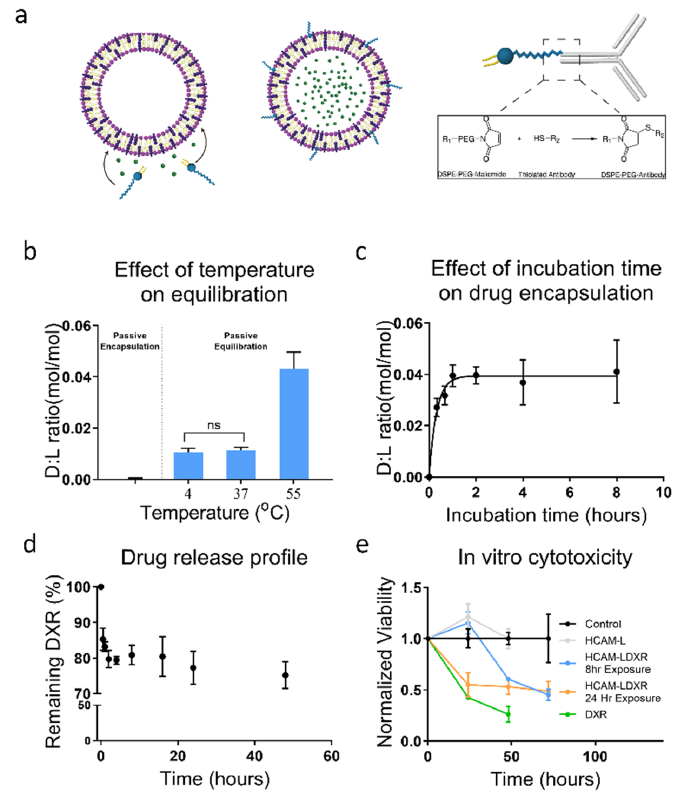
Figure 3. Thermal equilibration ( a ) Schematic of liposome encapsulation via thermal equilibration and conjugation with DSPE-PEG-MAL linked to an antibody. ( b ) The effect of temperature on equilibration was investigated by incubating DXR and liposomes at 4, 37, and 55 °C for 1 h and comparison with liposomal DXR created via passive encapsulation. E T increases D:L nearly 200 folds compared to passive encapsulation, and even at low temperatures, DXR is associated with liposomes. ( c ) Effect of incubation time on encapsulation for optimization. The liposomes showed a time-dependent increase in DXR encapsulation up to 1 h, however, beyond 1 h there was very little change. ( d ) Evaluations of DXR release profile at 37 °C in PBS with 10% FBS. A controlled escape of DXR from liposomes, with 75% (±37%) of the DXR remaining in the liposomes after 48 h was observed. (e) Targeting ability and cytotoxicity of anti-HCAM conjugated DXR liposomes on breast cancer cells. MDA-MB-231 DSPE-PEG-MAL was integrated within the membrane during equilibration and incubated with an antibody (HCAM). These targeted liposomes were cytotoxic to MDA-MB-231 cells in vitro, with a 52% decrease in cancer cell viability following 3 days of incubation. All measurements on the encapsulated DXR concentrations were determined using spectrometry and comparing absorbance values to a standard curve of known concentrations. Data were taken on at least 3 independently produced samples ( n = 3) and measurements on each sample were made in triplicate.